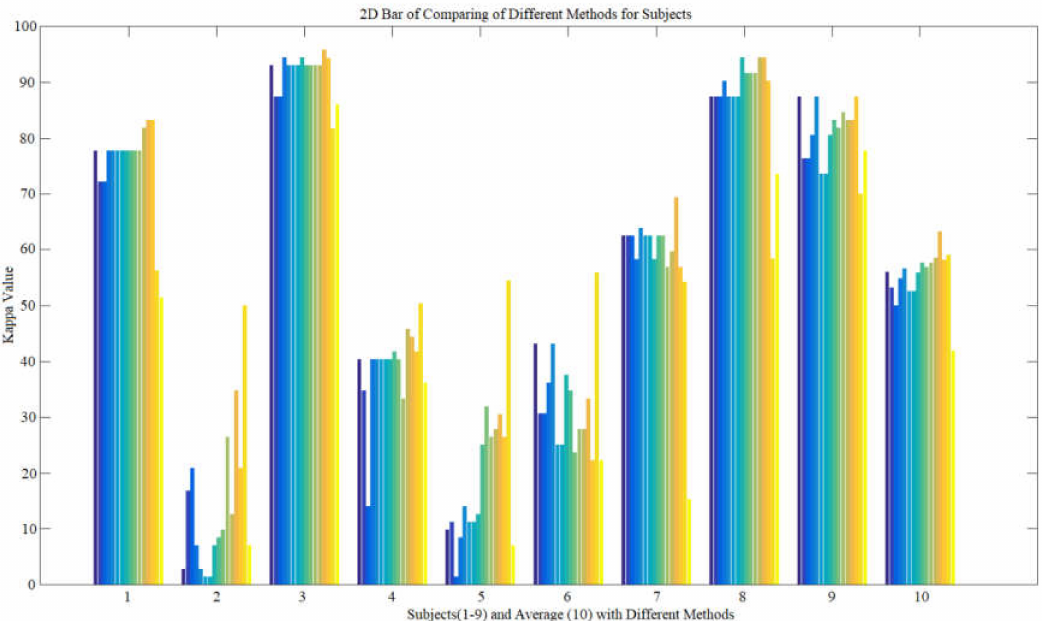
Figure 17. Checking the best kappa results of different methods compared with the proposed method.